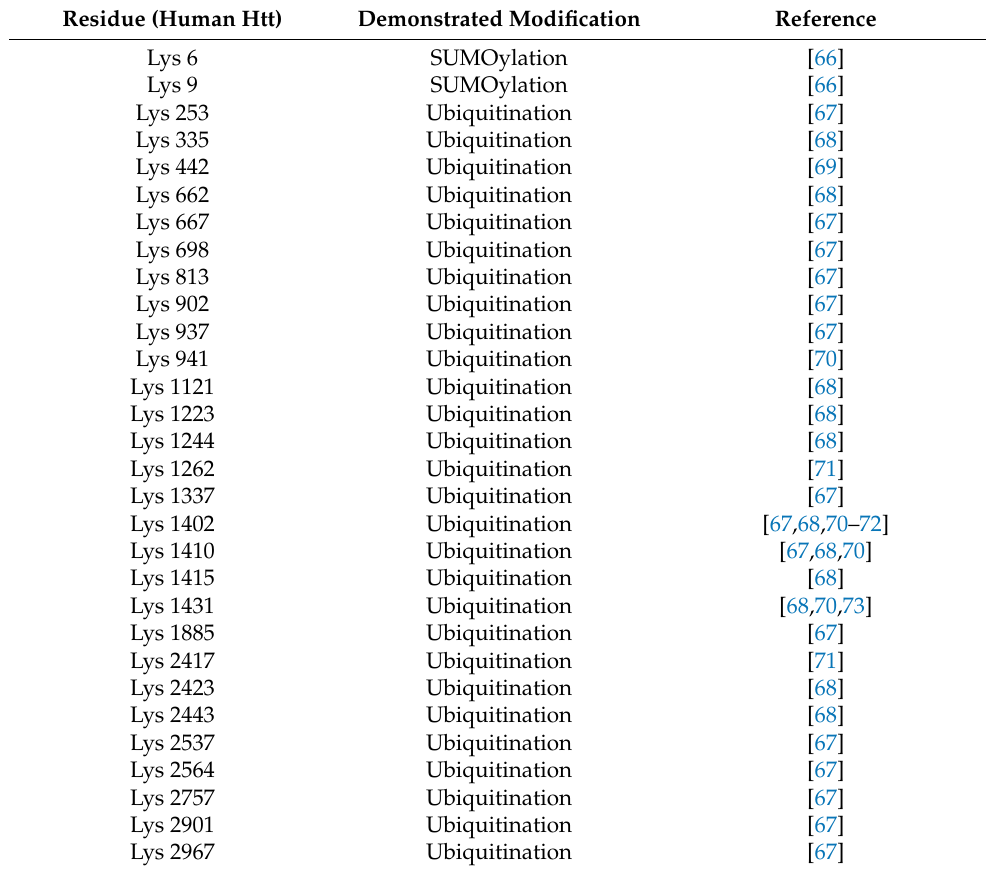
Table 1. List of ubiquitinated and SUMOylated residues in human Htt, according to PhosphoSitePlus